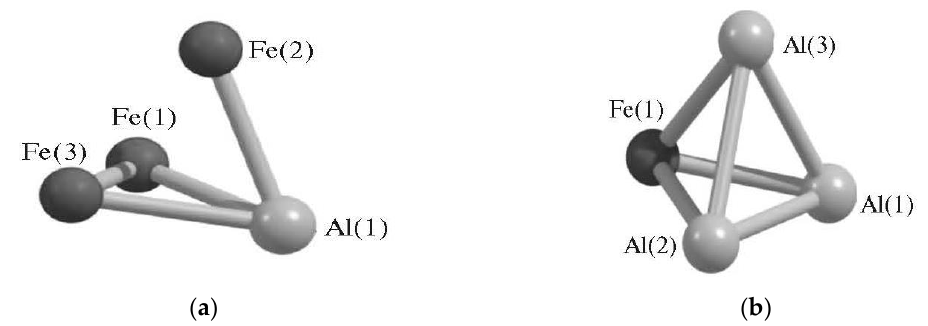
Figure 1. The images of molecular structures of most stable AlFe 3 ( a ) and Al 3 Fe ( b ) isomers [76].